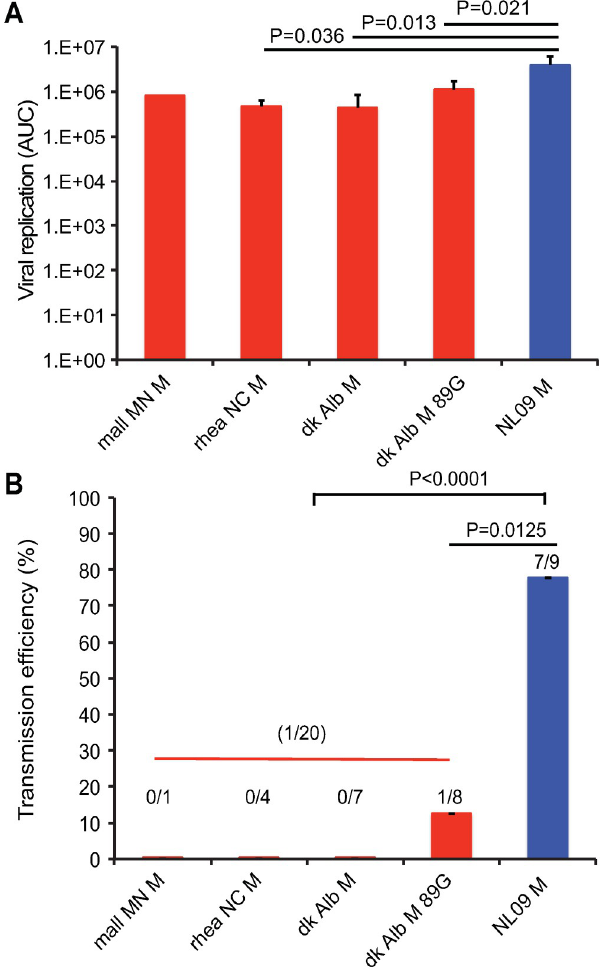
Fig 3. pH1N1 influenza A virus M segment confers efficient replication and transmission of PR8-based virus among guinea pigs. Groups of four guinea pigs were inoculated with 10 PFU of each avian M-encoding virus or NL09 M-encoding virus, as indicated. (A) Virus replication in nasal wash was measured by plaque titration at days 2, 4, 6, and 8 post-infection and the area under the curve was calculated. Graphs show mean AUC with SD for three experiments. All avian M-encoding viruses exhibited lower levels of growth in vivo than the isogenic virus possessing the NL09 M segment. The replication differences between avian M and NL09 M-based viruses were statistically significant, whereas those among avian M-based viruses were not. Statistical significance was evaluated using an unpaired, two-tailed Student’s t-test. (B) To assess transmission, each inoculated guinea pig was treated as an independent biological sample. The pH1N1 M segment conferred efficient transmission to na ï ve animals that were contact exposed (7/9 transmissions; 78%). In contrast, significantly poorer (12%), or no transmission was observed from guinea pigs infected with PR8 avian M viruses to na ï ve cage mates. Statistical significance of transmission differences were evaluated using an unpaired, two-tailed Student’s